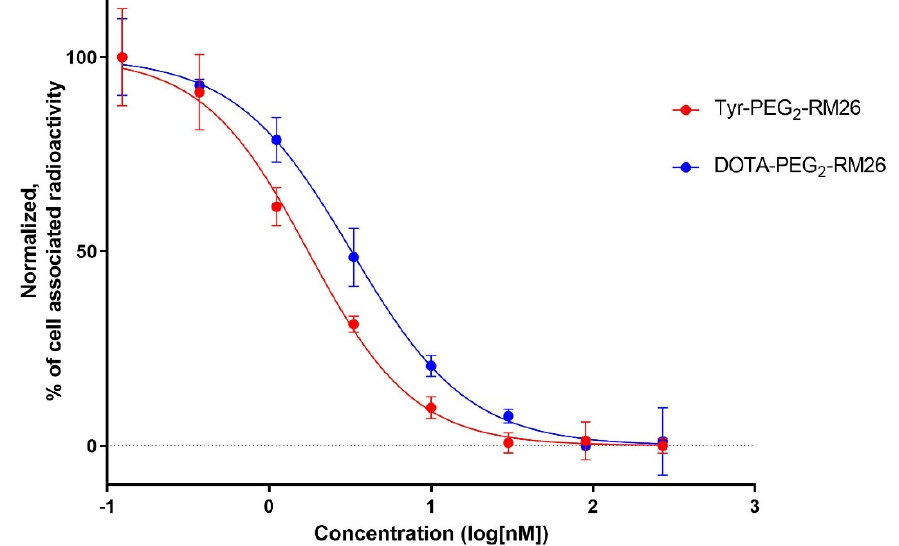
Figure 4. Inhibition of [ 111 In]In-NOTA-PEG 4 -RM26 binding to PC-3 cells with X-PEG 2 -RM26 (X = tyrosine, DOTA). Data are presented as the mean value of three dishes ± SD.